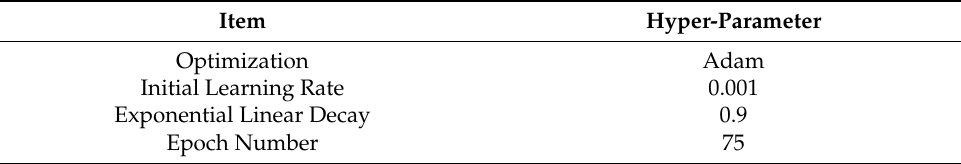
Table 1. Experiment Hyper-parameter Details.